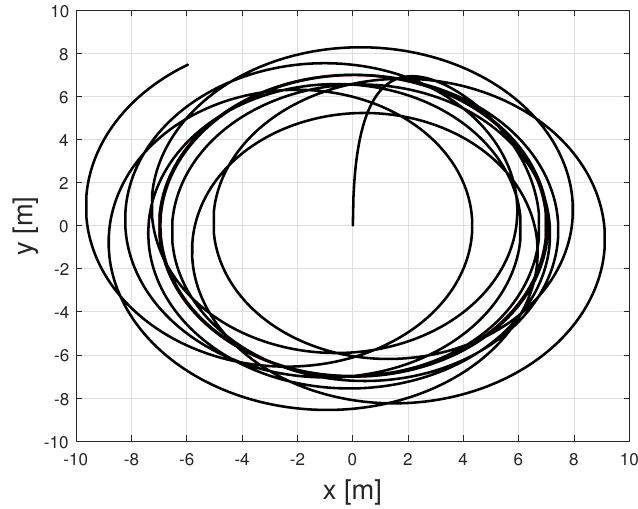
Figure 4. UGV circle trajectory with an actuator